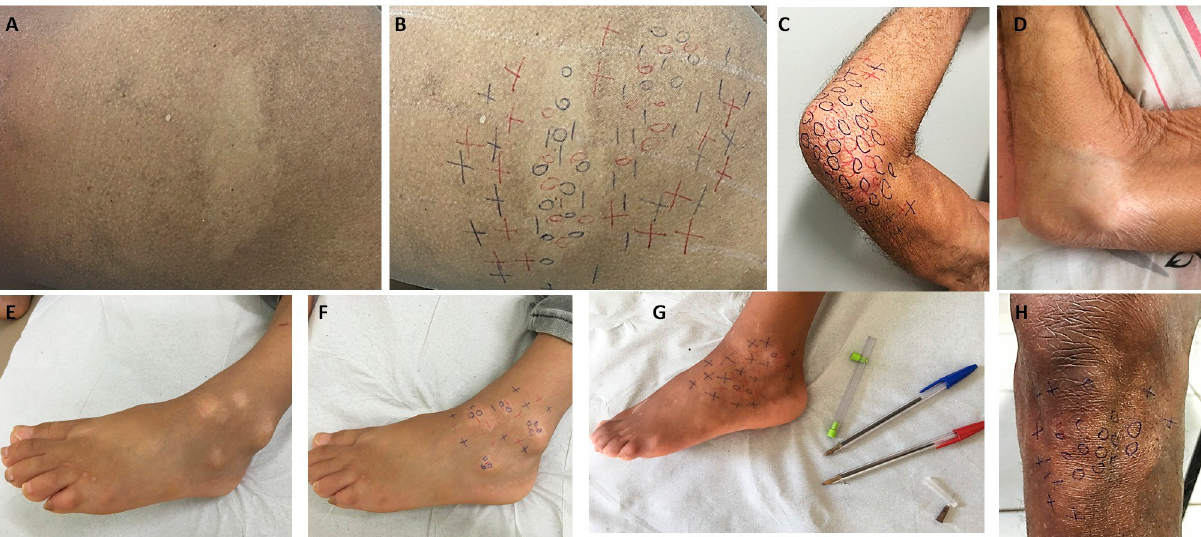
Fig 2. Images of different locations (buttock, elbow, foot, and knee) of leprosy lesions. (a) Hypochromatic macule on the left buttock; (b) the same patient, after performing the endogenous histamine test, below the initial macule observed, another hypochromatic, hypo-anesthetic macule became more evident due to the erythema surrounding the lesion; (c) hypochromatic anesthetic macule on the right elbow; (d) residual hypochromatic macule on the right elbow after 12 months of multi drug therapy; (e-f) hypochromatic hypo-anesthetic macules on the left foot; (g) the same previous patient with improvement of skin sensitivity with more normoesthesic points; (h) hypochromatic hypo-anesthetic macule on the left knee. Legend: 0 (anesthetic point); —(hypoesthetic point); + (normoesthesic point). All individuals were tested for anti-PGL-I antibodies. Among 64 leprosy patients, 45 (70.3%) provided SSS (earlobes, elbows and/or skin lesion) for M . leprae DNA (RLEP) by PCR.